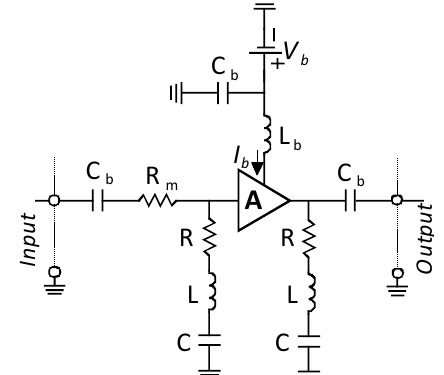
Figure 11: Simulated one stage NGD circuit. ( R = 36 Ω , R = 22 Ω , L = 33 nH, C = 0.5 pF, L The tested NGD device is biased at the DC voltage V = 3.9 mA. and I b